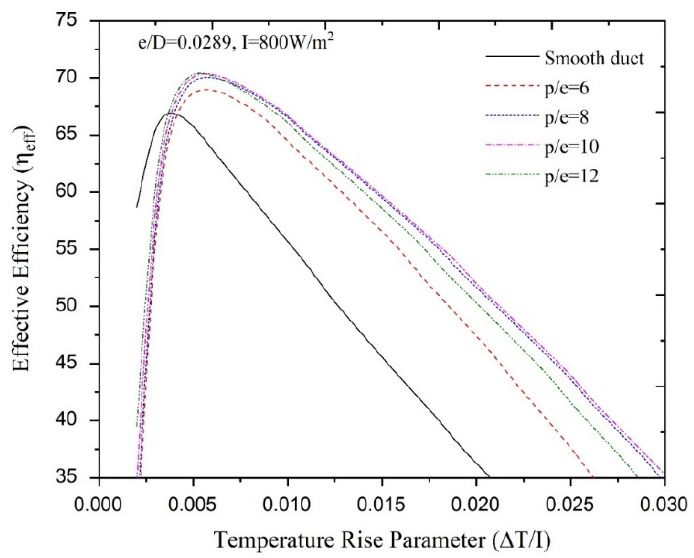
Figure 8. Effect of temperature increase parameter on effective efficiency. Table 4. Ranges of temperature increase parameters and Reynolds numbers.